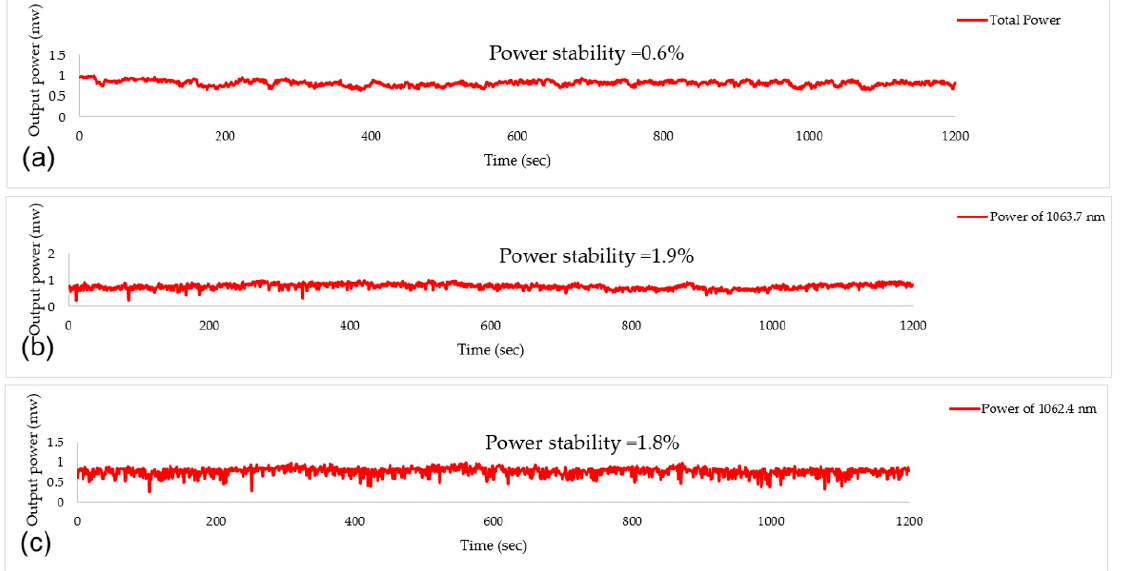
Figure 8. The measured ( a ) total power for σ - π configuration, ( b ) power of 1063.7 nm in σ - polarization, ( c ) power of 1062.4 nm in π - polarization.